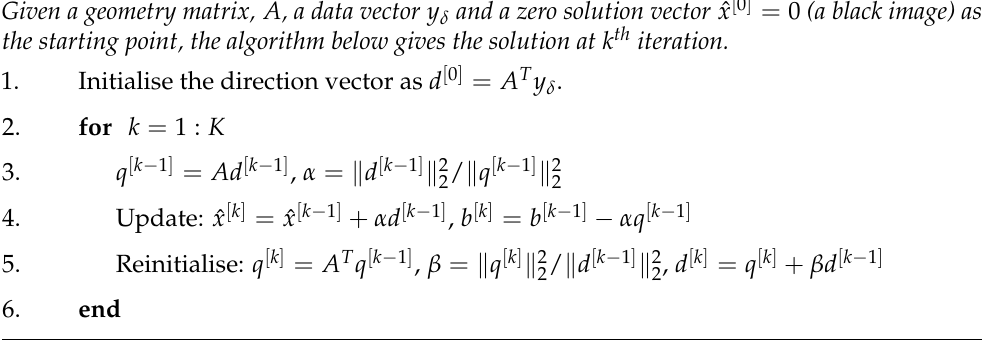
Algorithm A5 Conjugate Gradient Least Squares (CGLS).